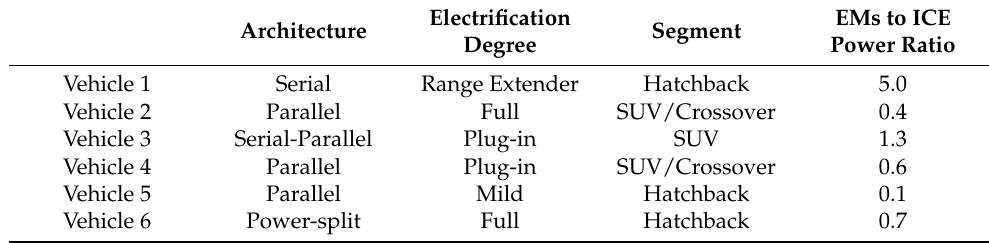
Table 2. Vehicles naming and description.